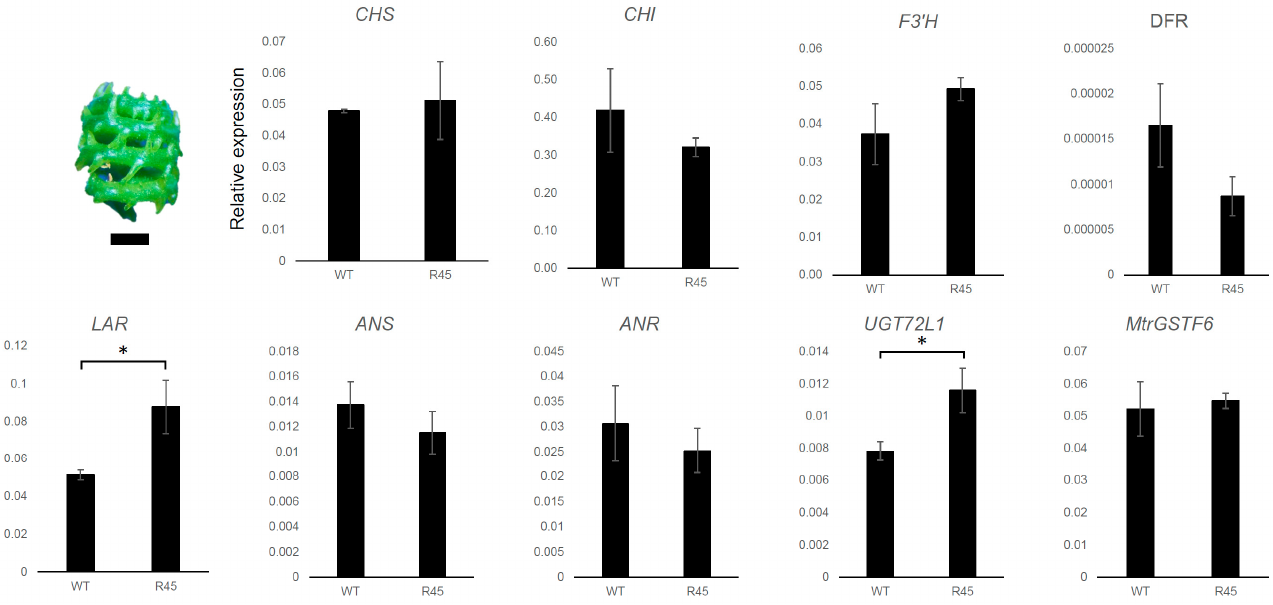
Figure 11. Gene expression in pods of M. truncatula R108 (WT) and mutant (R45). The stage of the sampled pods is shown (bar = 1 mm). Expression levels are calculated as in legend of Figure 9 (* p < 0.05).